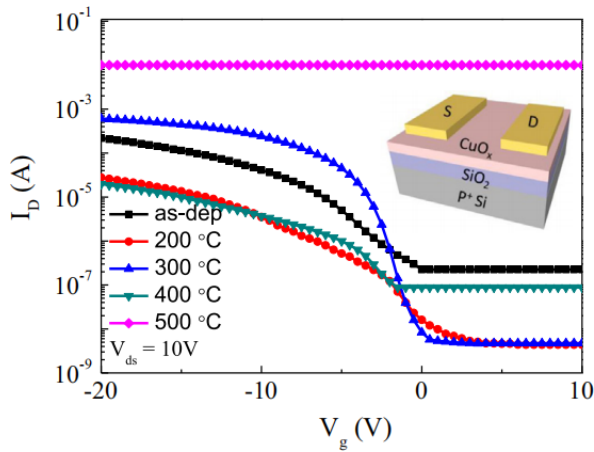
Figure 6: Transfer characteristics of the CuO x TFTs with various annealing temperatures